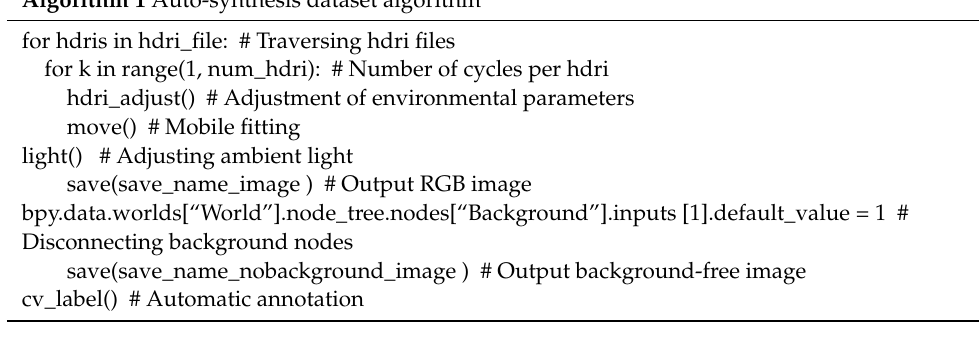
Algorithm 1 Auto-synthesis dataset algorithm